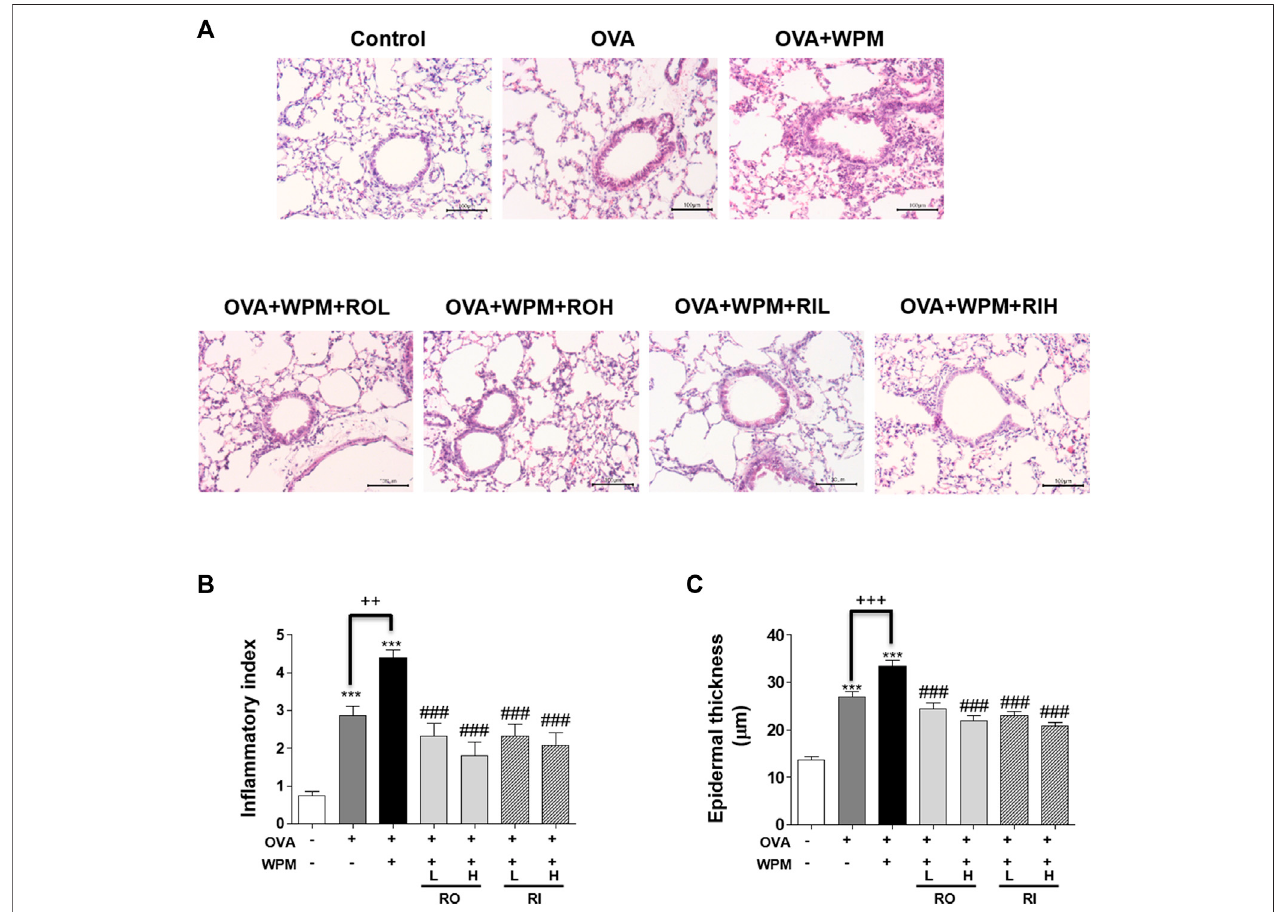
FIGURE2| TheeffectsofRLonhistopathologicalchangesinaWPM-exacerbatedmousemodelofasthma.Lungtissueswerecollectedand fi xedin10%formalin. (A) Then the sections were cut and stained with H&E solution. (B) In fl ammatory cell in fi ltration in lung tissues was scored as described in the Materials and Methods section. (C) Thethicknessofthelungbronchialepitheliumwasquanti fi edusingImageJsoftware.Alldataarepresentedasthemean±SEM. n =4 – 5/group.*** p < 0.001 compared with the control group; ### p < 0.001 compared with the OVA+WPM group; ++ p < 0.005 and +++ p < 0.001 compared with the OVA group.